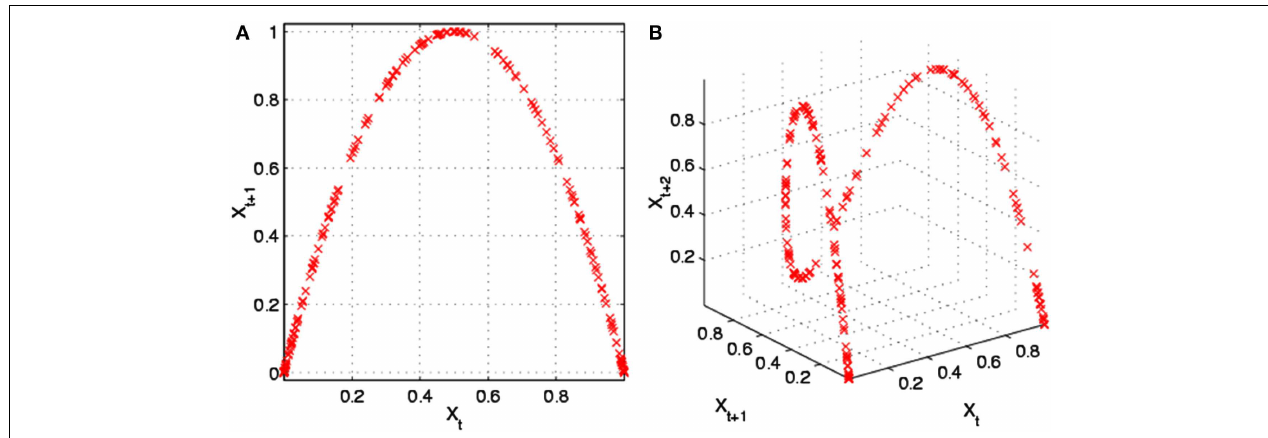
FIGURE 12 |The Hénon strange attractor in its chaotic mode. Adapted from public source: http://en.wikipedia.org/wiki/H%C3%A9non_map